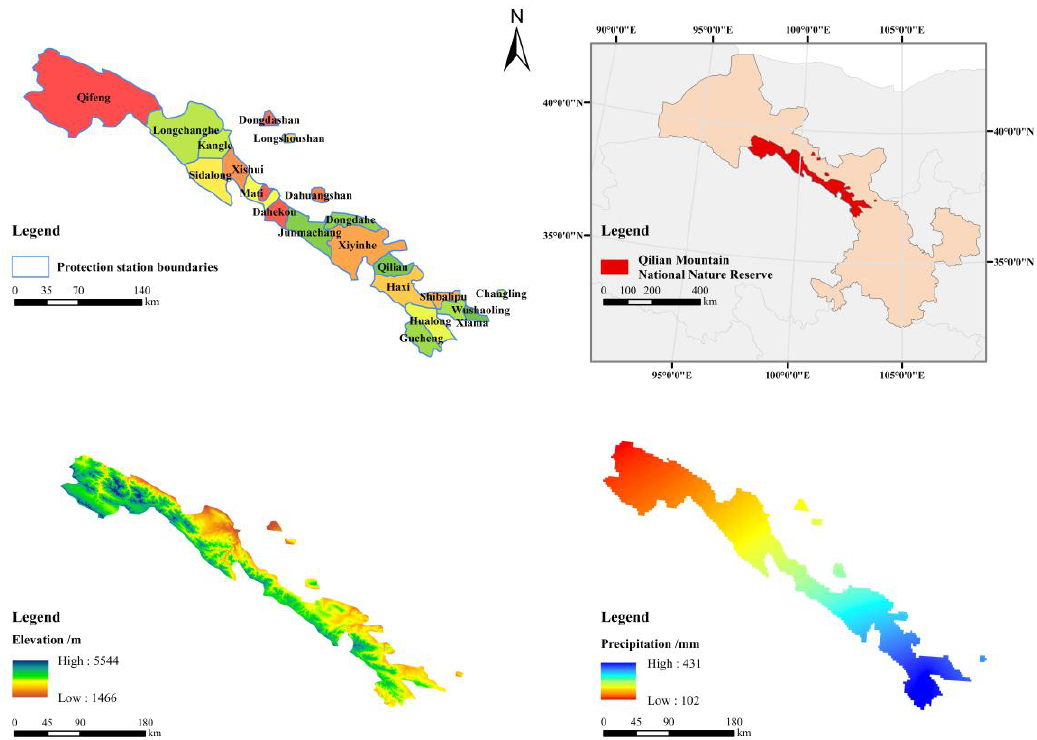
Figure 1. Overview map of Qilian Mountain National Nature Reserve (QMNR). Note: Figure 1 is composed of four maps: the distribution map of the protection stations of Qilian Mountain National Nature Reserve, the geographic location of the nature reserve, the elevation map and the precipitation distribution map.